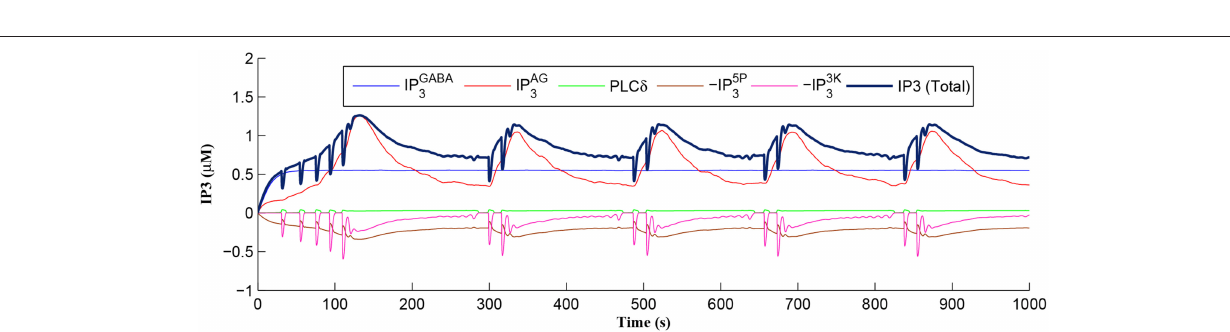
FIGURE 6 | GABA released from the GABA interneuron as a function of time. Under the input spike stimulus of f GABA , GABA increases and then stabilized.